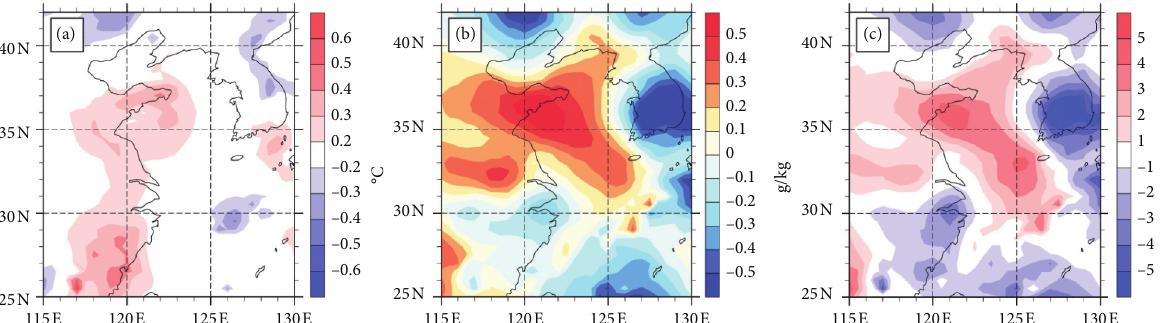
Figure 15: Initial differences of temperature (a), mixing ratio (b), and relative humidity (c) near the surface between Exp-B_CV6 and Exp- B_CV5 (the former minus the latter).